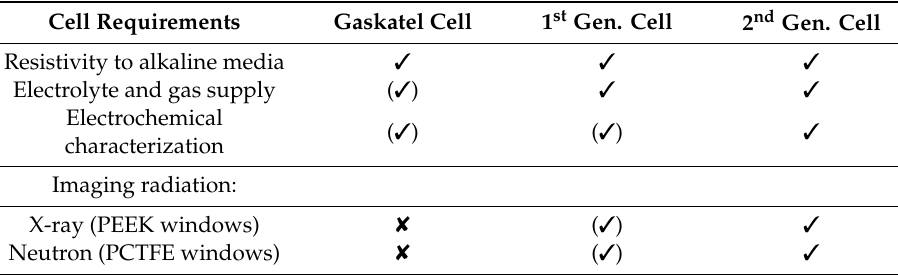
Table 1. Development of cell capabilities.